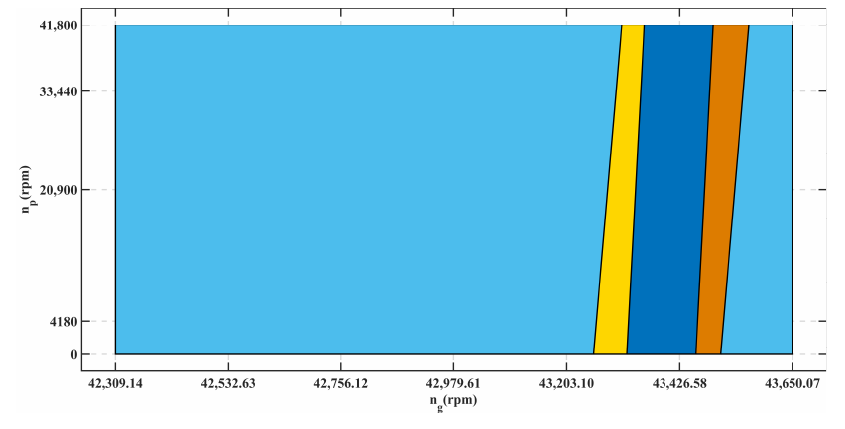
Figure 3. The partition of state space: N y = 3.